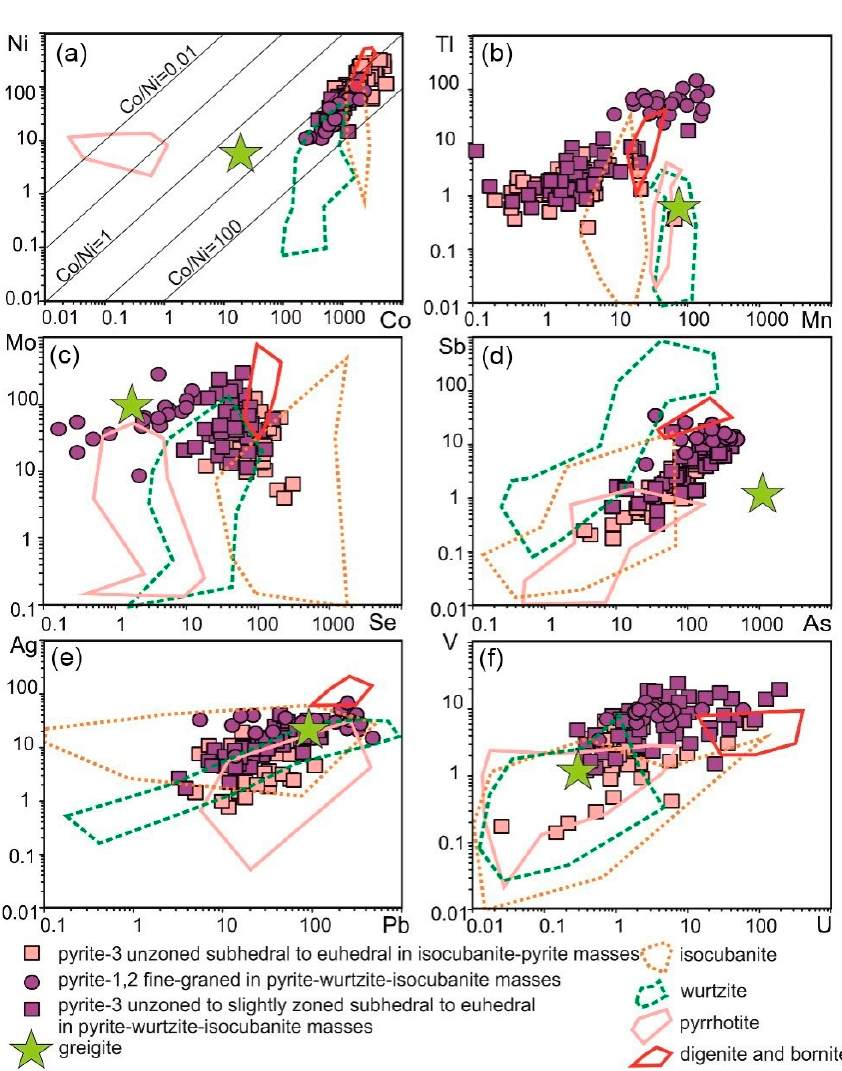
Figure 3. Diagrams showing trace element concentrations in sulfides from isocubanite-pyrite (pink) and pyrite-wurtzite-isocubanite (purple) microfacies. ( a ) Co vs Ni ratio; ( b ) Mn vs Tl ratio; ( c ) Se vs Mo ratio; ( d ) As vs Sb ratio; ( e ) Pb vs Ag ratio; (f) U vs V ratio.